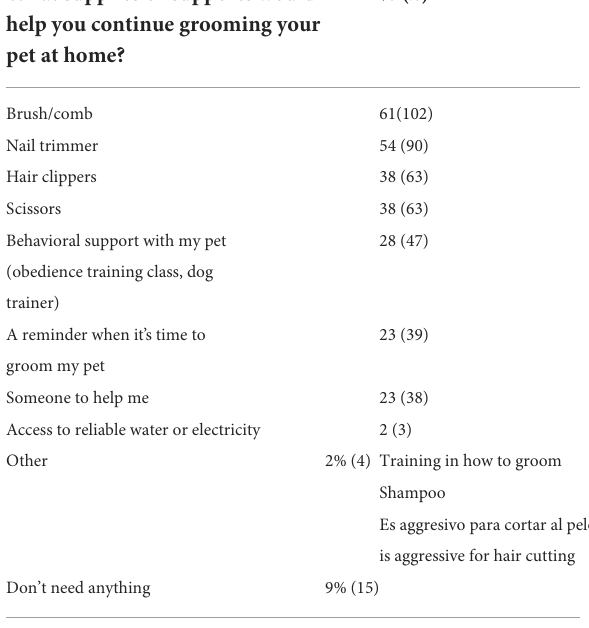
TABLE 2 Barriers to grooming